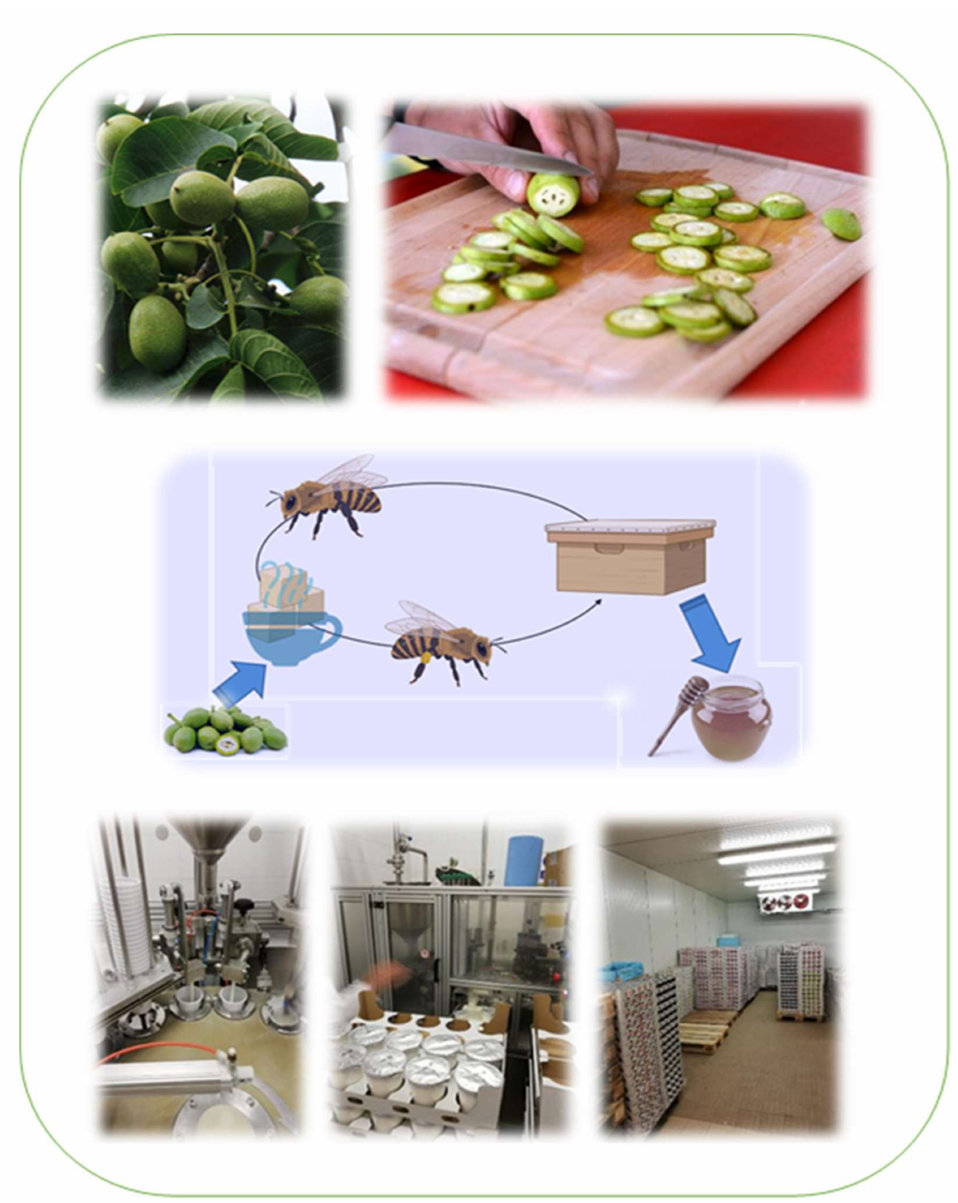
Figure 4. Different steps in producing the honey yogurt for the clinical trial. First, the green walnuts were collected (upper photos), selecting the desired part from the green fruits to make the syrup to feed the bees (middle photos). After producing the honey from green walnuts, it was mixed with yogurt in the packaging in the factory (lower